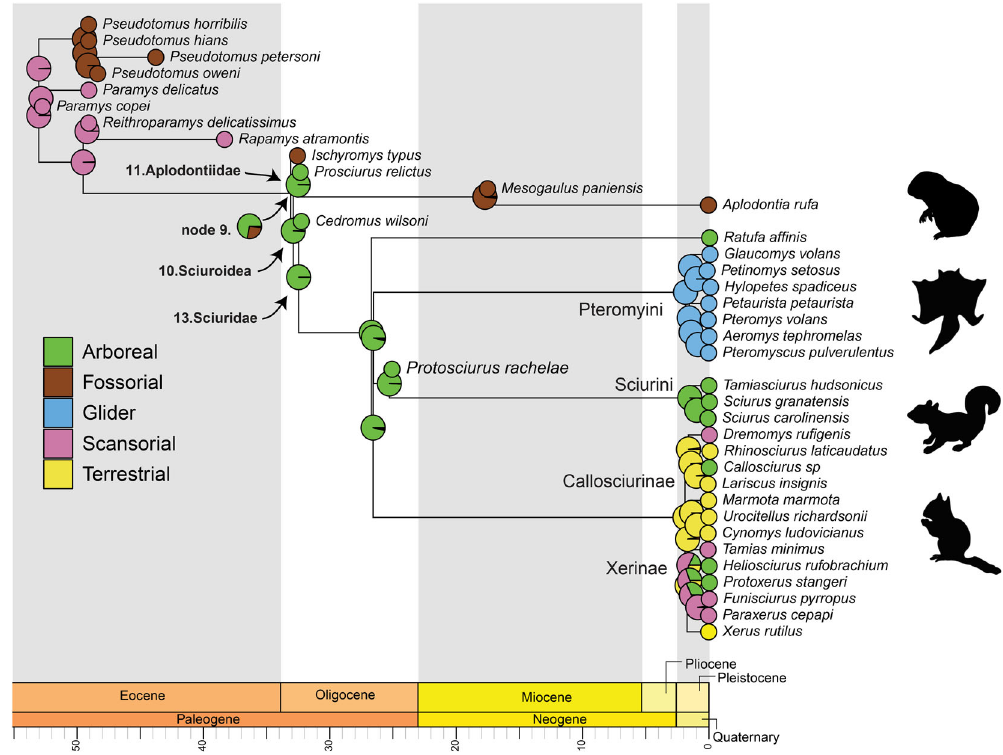
Fig. 6 Ancestral state reconstruction of the locomotor behaviour with a geological timescale. Each behavioural category is represented by a different colour. Gliding and terrestrial behaviours are only present in extant species, while scansoriality, fossoriality and arboreality are displayed by extinct and extant